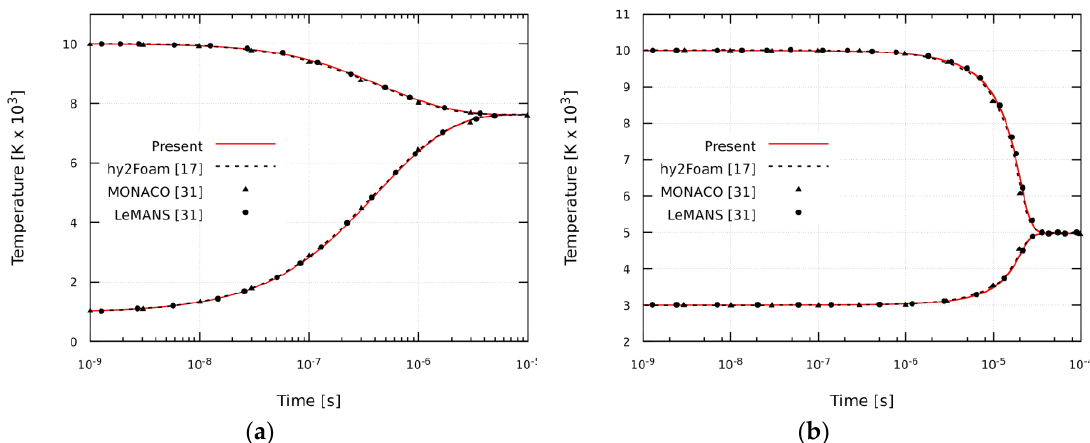
Figure 6. Vibrational translational relaxation towards equilibrium of a nitrogen heat bath: ( a ) vibrational heating; ( b ) vibrational cooling [17].